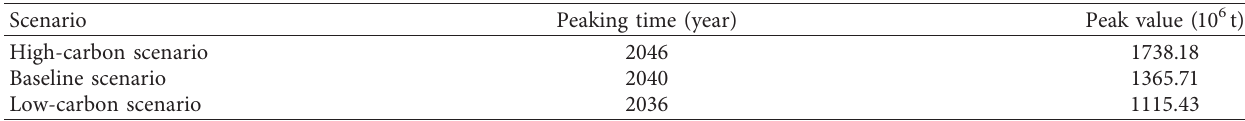
Table 6: Prediction on peak values of different